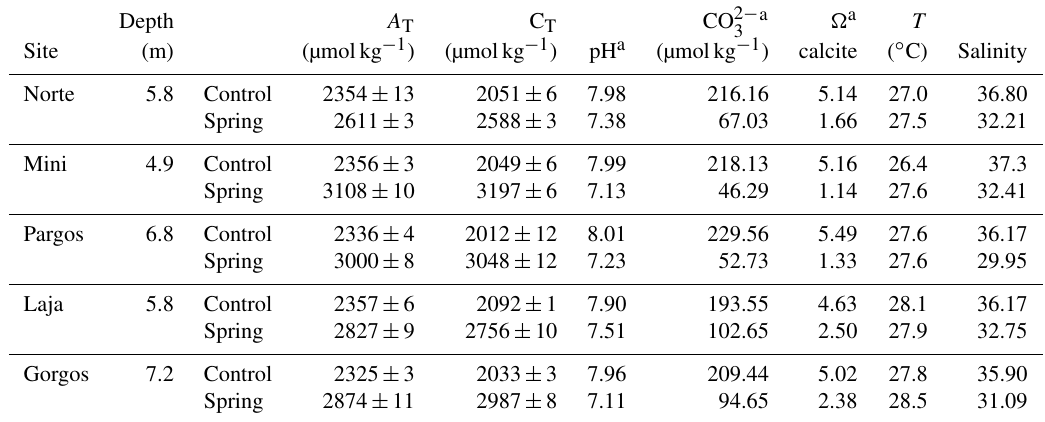
Table 1. Carbonate chemistry parameters of discrete water samples collected at low-saturation-state submarine springs and adjacent high-